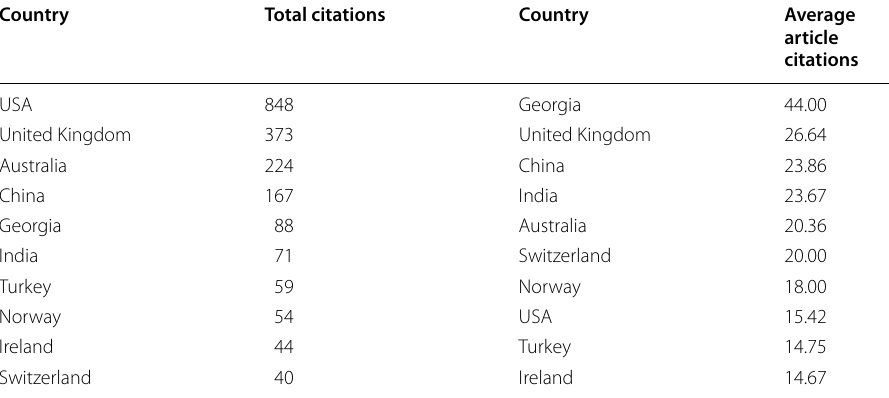
Table 5 Countries producing the highest impact in terms of total citations and average article